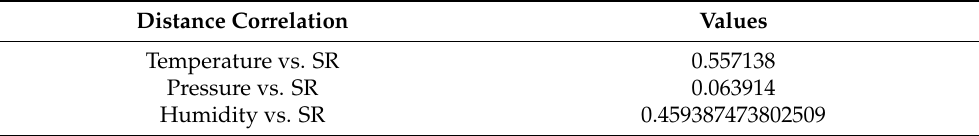
Table 2. Results for correlation of distance between SR and temperature, humidity, and pressure.